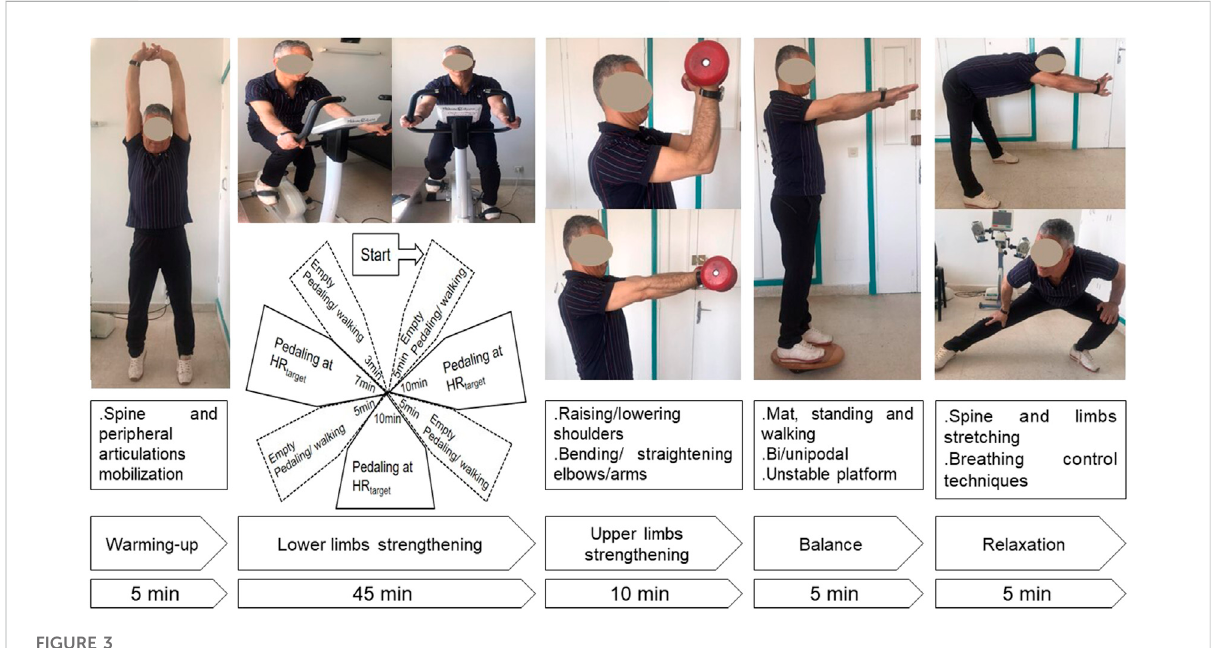
FIGURE 3 Description of an exercise training session. HR,